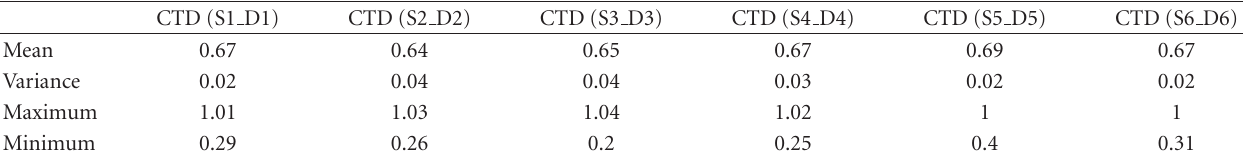
Table 5: The values of the CTD